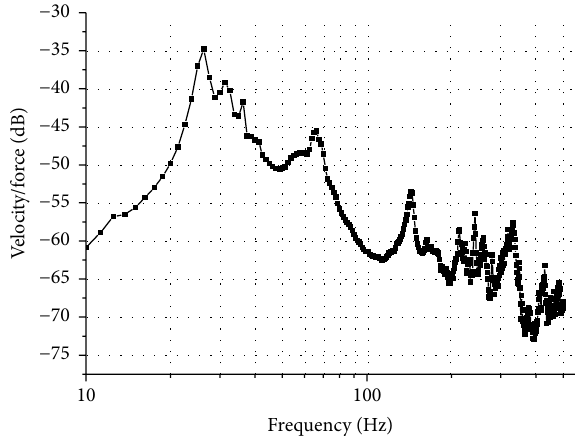
Figure 20: Average velocity response function of the control base (dB-Reference: 0 dB = 1 m/s/N).